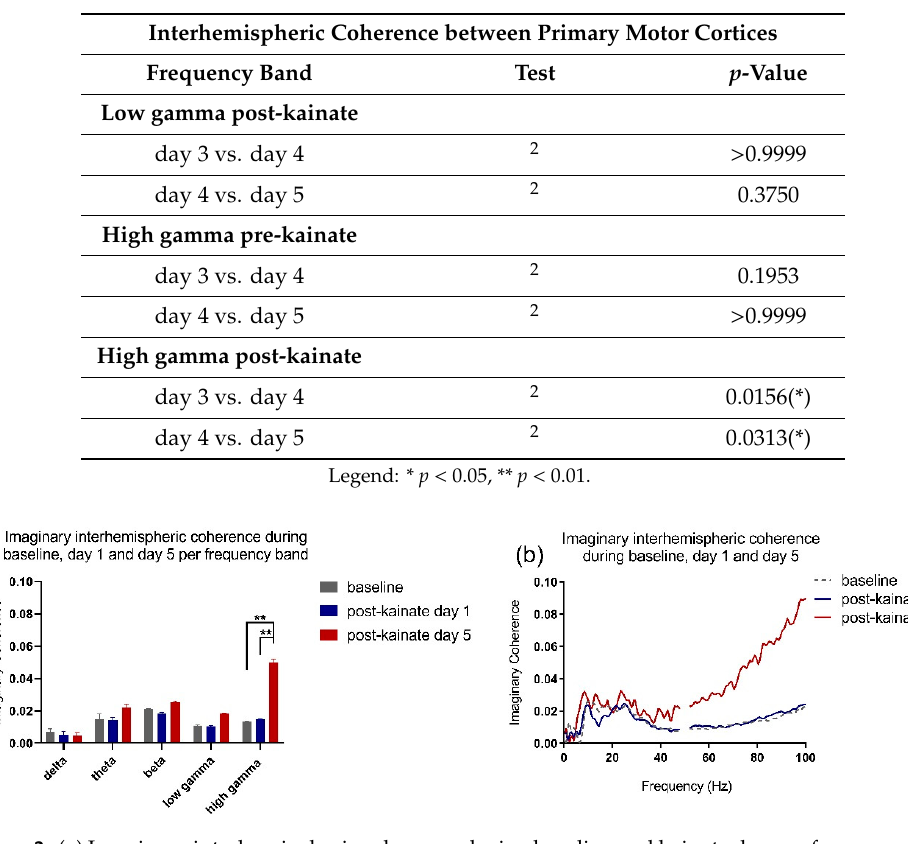
Figure 3. ( a ) Imaginary interhemispheric coherence during baseline and kainate day per frequency band. Results are expressed as average ± the standard error of the mean. ( b ) Imaginary interhemispheric coherences across 0.5–100 Hz frequencies (average) (** for p < 0.01). Table 2. Imaginary interhemispheric coherence between primary motor cortices. Statistical data (Figure